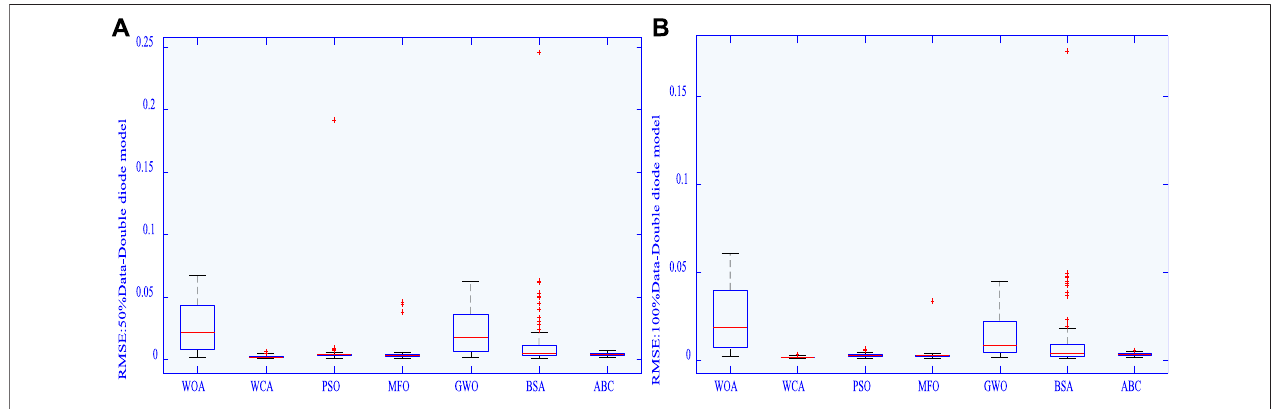
Frontiers in Energy Research |